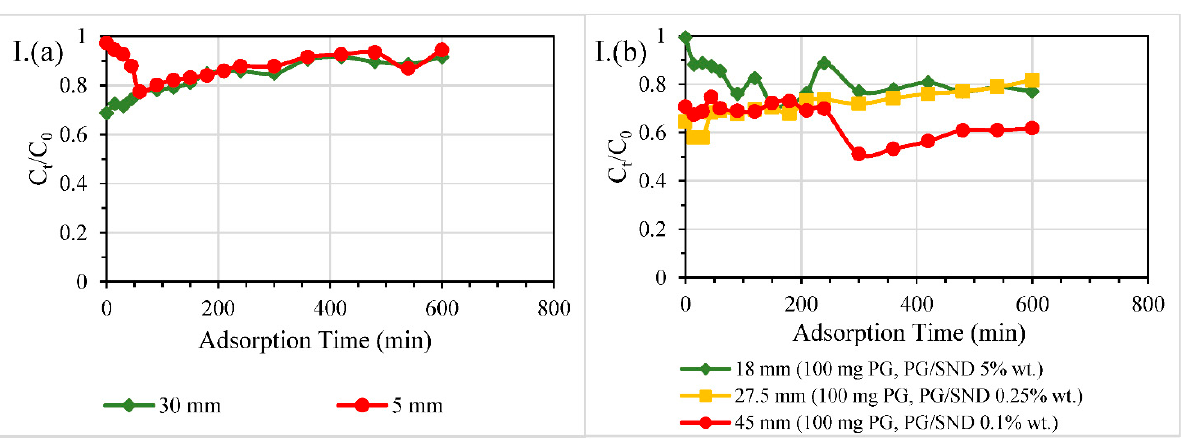
Figure 6. ( I ) ATL, ( II ) CBZ, ( III ) CIP, ( IV ) DCF, ( V ) GEM, ( VI ) IBP adsorption onto PG/SND (PG at 0.5% wt.) filter medium in different column sizes ( a ) 18 mm ID ( b ) 40 mm ID. Experimental conditions: ECs-contaminated DW influent adjusted at 10.5 mg/L of EC; room temperature at 22 ± 3